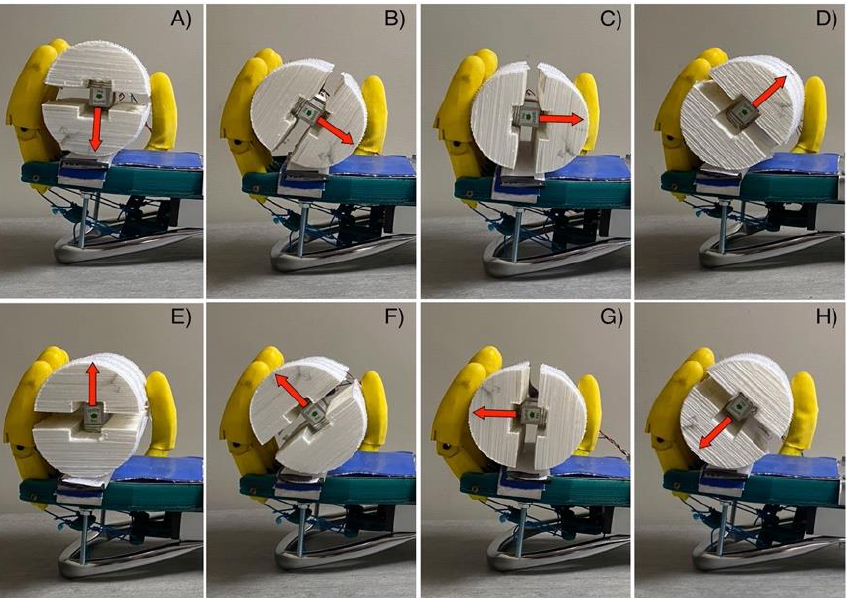
Figure 9. Experimental test of power grip force measurement, with the handlebar in eight different position with respect to the prosthesis palm: ( A ) 0 degrees; ( B ) 45 degrees; ( C ) 90 degrees; ( D ) 135 degrees; ( E ) 180 degrees; ( F ) 225 degrees; ( G ) 270 degrees; ( H ) 315 degrees. The red arrow represents the load cell sensing axis.